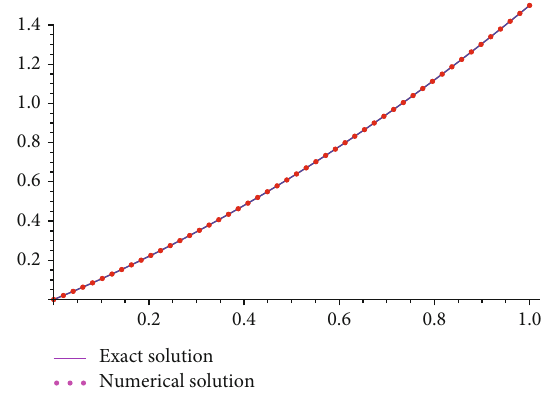
Figure 21: Absolute errors of u Example 3.